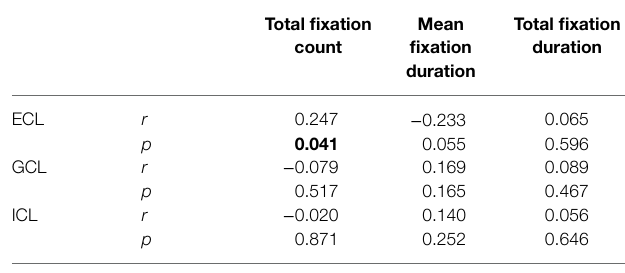
TABLE 9 | Selection frequencies of scaffolds. Scaffolds Selection frequencies